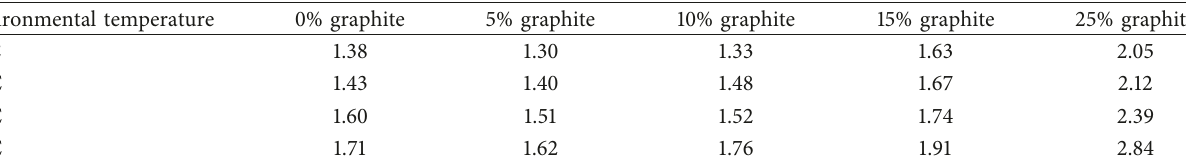
Table 2: Heat conductivity coefficient test results (W/mK).